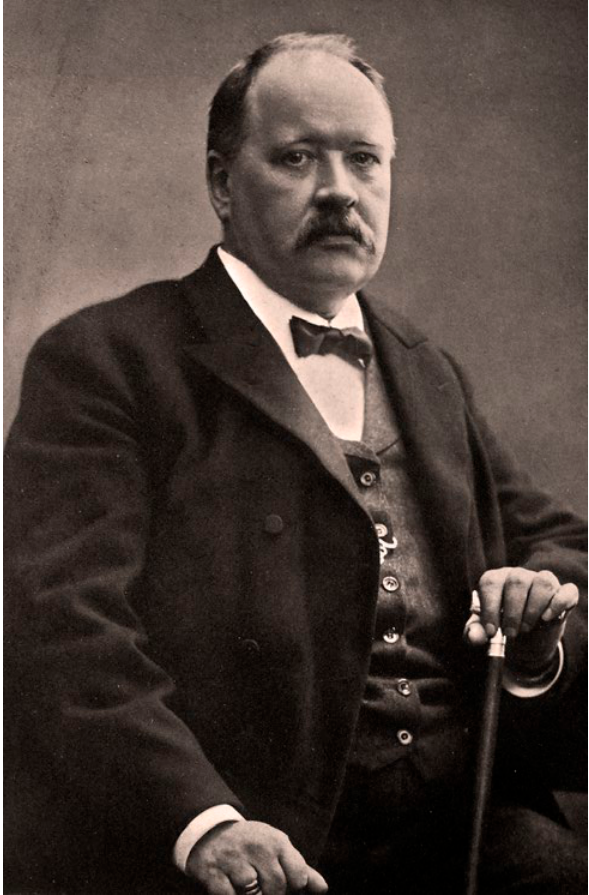
Figure 4a. Svante Arrhenius (1859–1927). Credit: University Archives, Universität